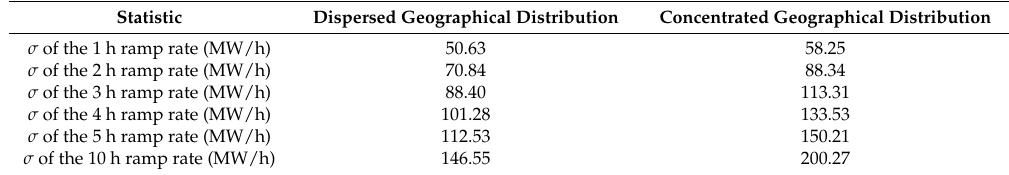
Table 3. The standard deviations ( σ ) of the ramp rates for different ramp lengths with dispersed and concentrated geographical distribution. The results are averages of the 100 MC